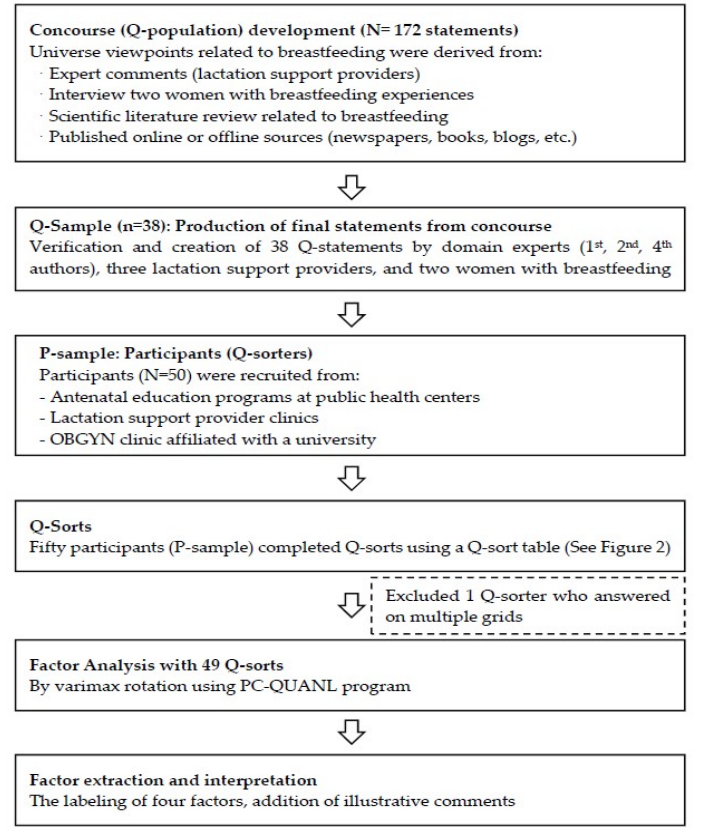
Figure 1. Q-methodology steps in current study.